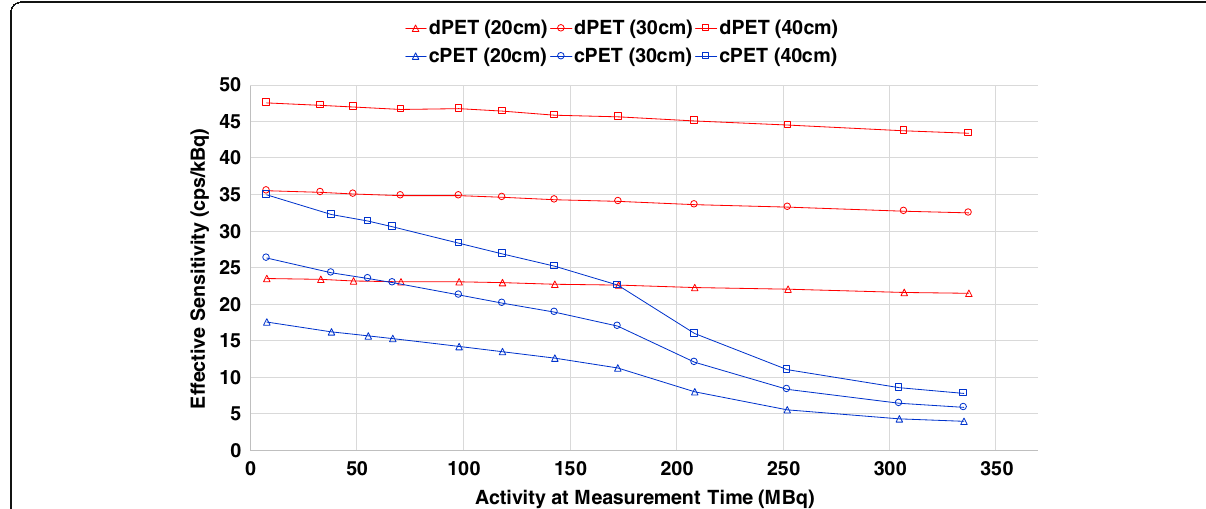
Fig. 11 Effective sensitivity of dPET (322 ps) versus cPET (550 ps) as a function of 18 F-FDG activities for object diameters of 20, 30, and 40 cm. It indicates a 1.3 – 5.5× effective sensitivity improvement of dPET with improved quality of counts compared to cPET over the measured activity of 7.4 – 337 MBq 18 F-FDG, although the NEMA sensitivity of dPET is lower than cPET ’